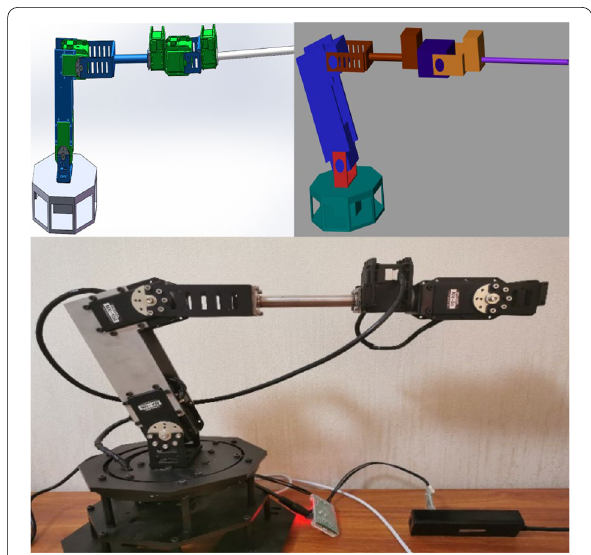
Figure 3 3D model, simulation model and actual